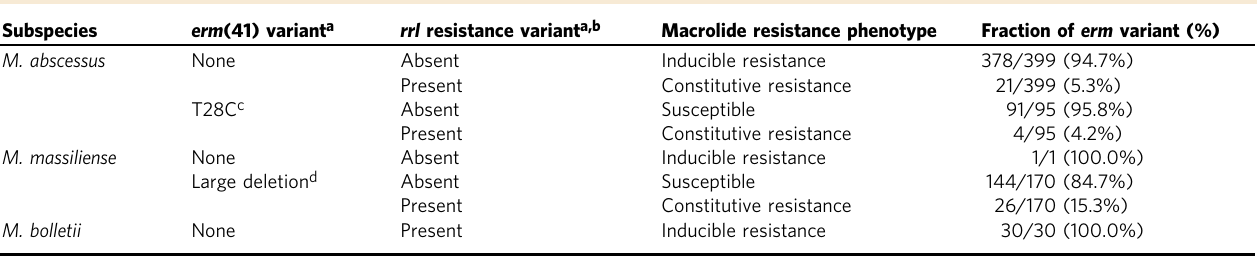
Table 1 Antimicrobial resistance markers for macrolides by MAB